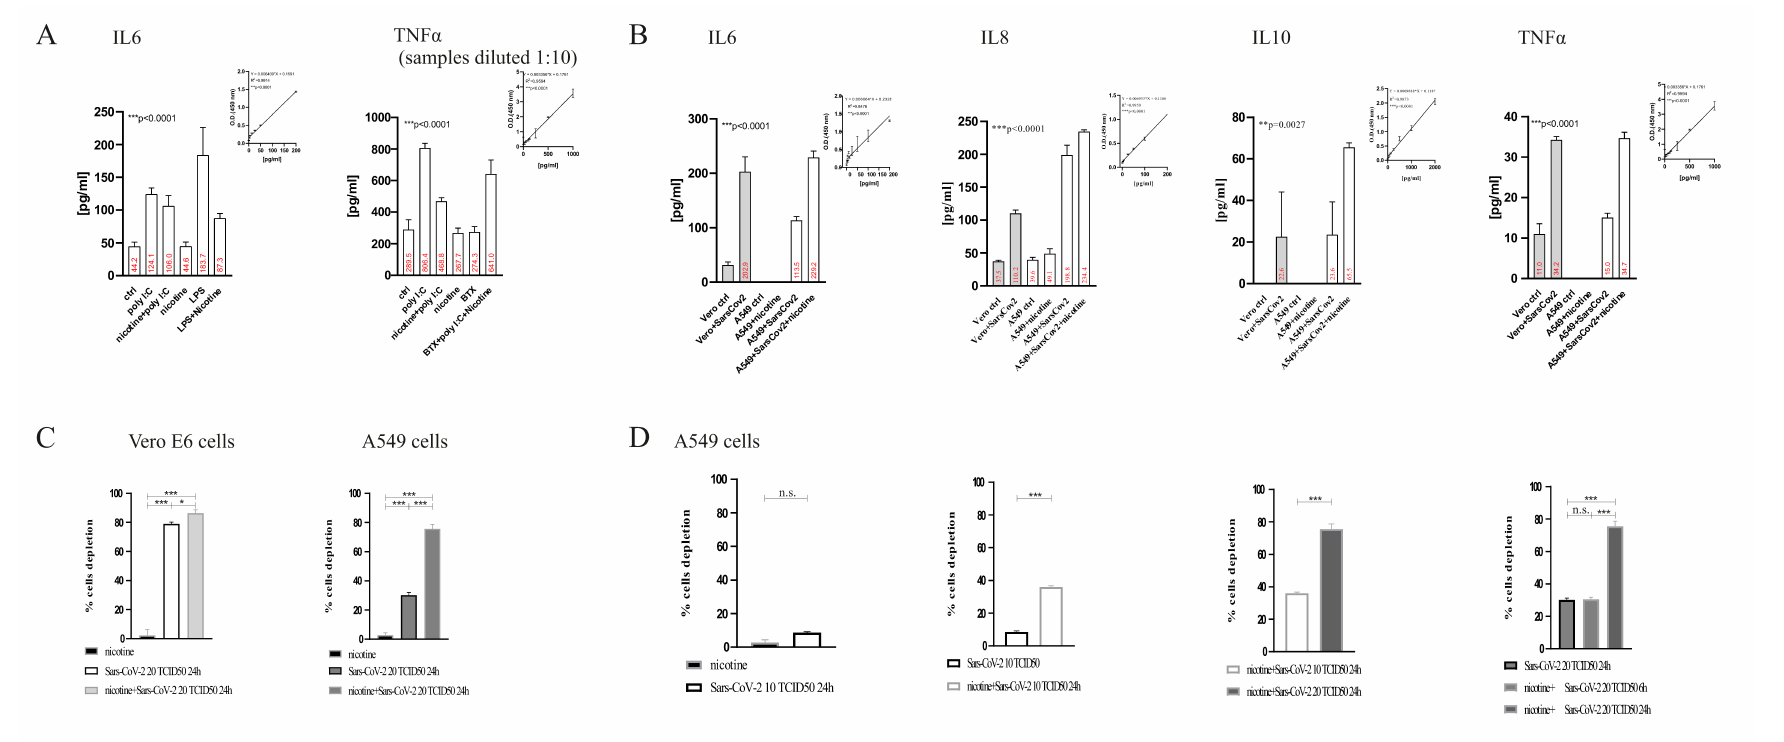
Figure 1. ( A ) Evaluation of IL6 and TNF α increase in A549 cells stimulated with LPS or poly(I:C). ELISA experiments; regression equation linearity, performed with Prism. Statistical significance was analyzed using one-way ANOVAs with multiple-comparison and post hoc tests with Bonferroni corrections. ( B ) Evaluation of IL6, IL8, IL10, or TNF α increase in A549 cells exposed to SARS-CoV-2. When histogram is not present it means that the values were below the sensitivity threshold of the test. See Materials and Methods for sensitivity thresholds for IL6, IL8, IL10, and TNF α , respectively. ELISA experiments; regression equation linearity, performed with Prism. Statistical significance was analyzed with one-way ANOVAs with multiple-comparisons and post hoc tests with Bonferroni corrections. ( C , D ) Evaluation of cell cytotoxicity in Vero E6 ( C ), and A549 cells ( D ). *** p < 0.001, ** p < 0.01, * p < 0.1; n.s. not significant p > 0.05 it is the